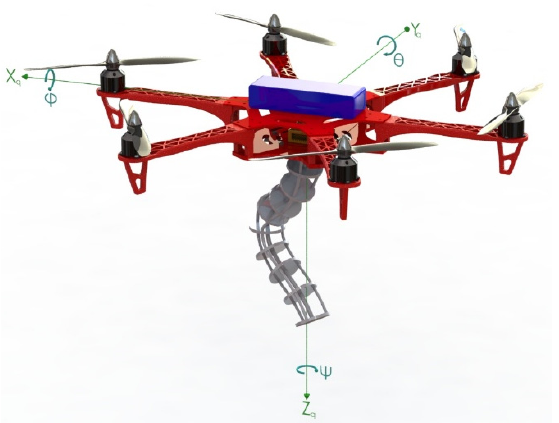
Figure 2. A hexa-rotor ACMS with a tendon-driven CR